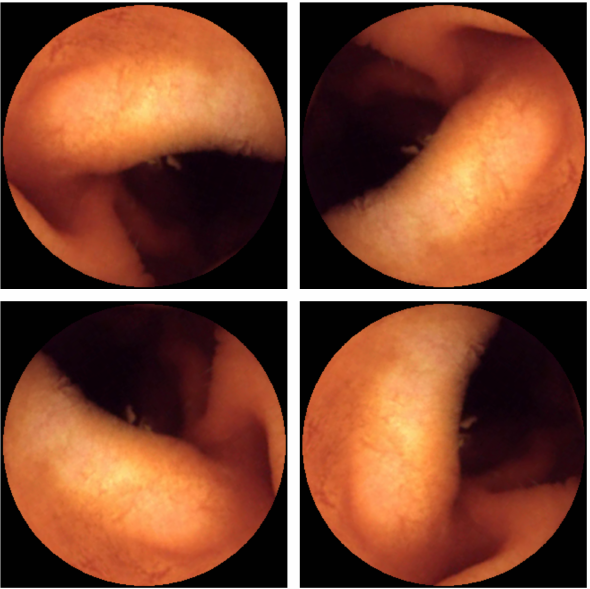
Figure 4. Rotation augmentation examples from KID video